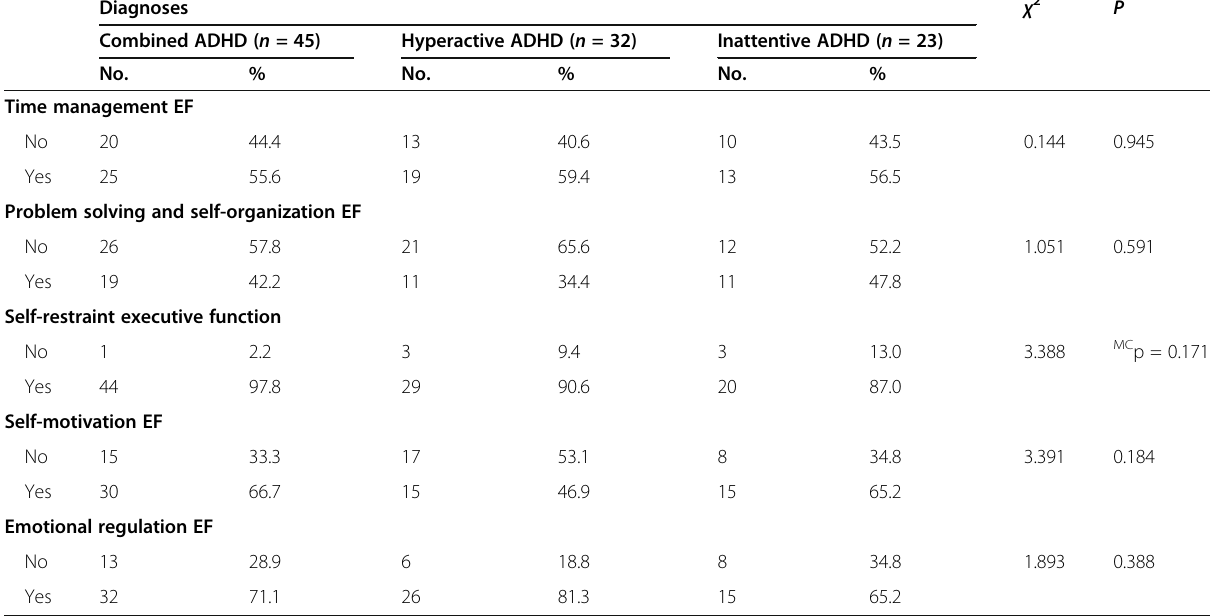
Table 2 Relation between EF and different ADHD subtypes